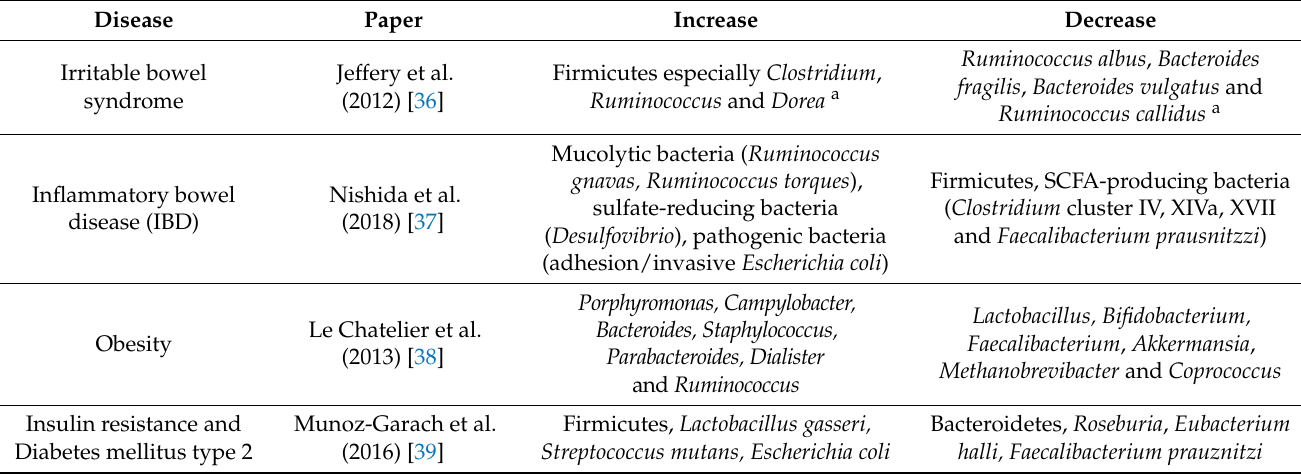
Table 1. Correlation of diseases with the changes in gut microbiota